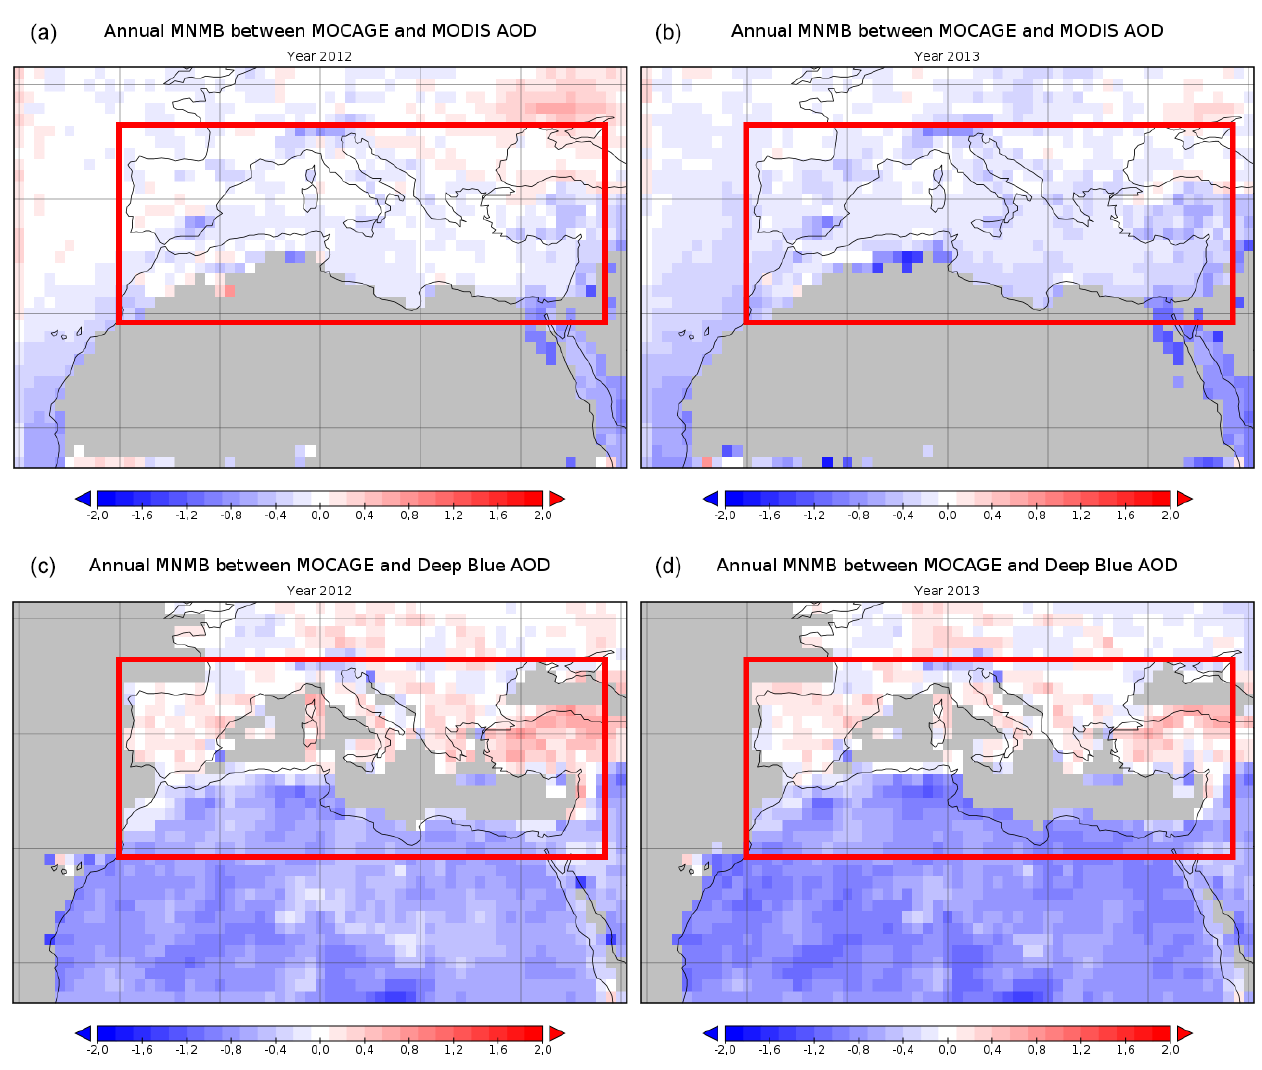
Figure 1. Map of the annual modified normalized mean bias (MNMB) of the aerosol optical depth against MODIS observations for the year 2012 (a, c) and 2013 (b, d) for MODIS (a, b) and Deep Blue (c, d)